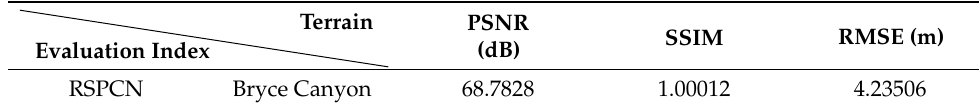
Table 6. Accuracy of RSPCN with different methods.